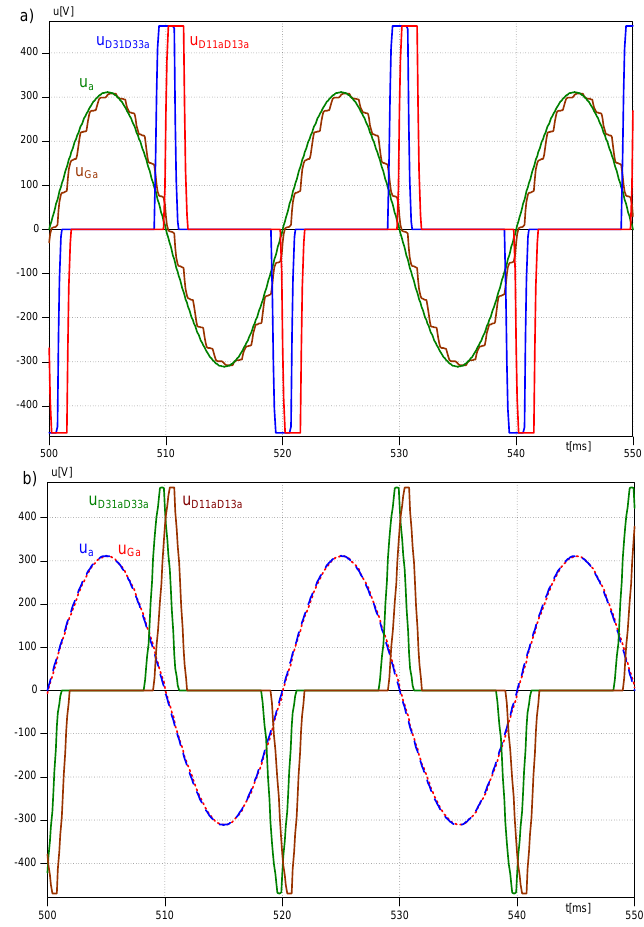
Figure 19. Line voltage u a and u Ga and voltage u D 11 aD 13 a and u D 31 aD 33 a waveforms on main windings of 3CRλ1 and 3CRλ3 units: ( a ) rated load, ( b ) 10% load.